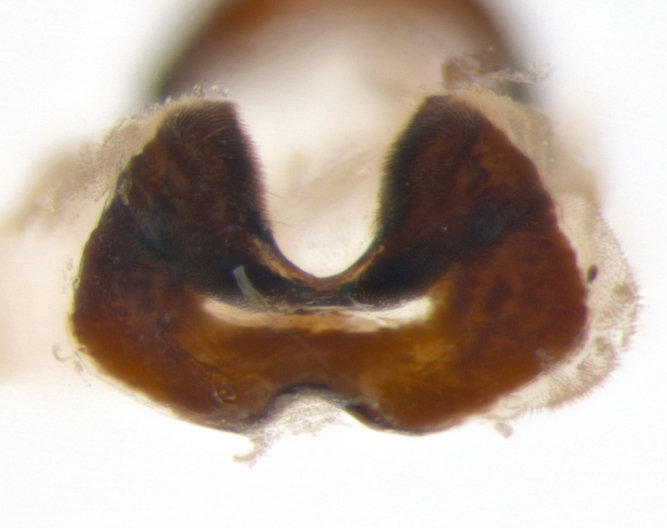
sternite 5, ventral view